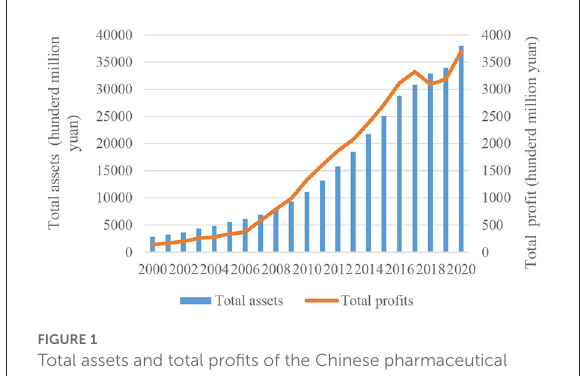
FIGURE1 Total assets and total profits of the Chinese pharmaceutical